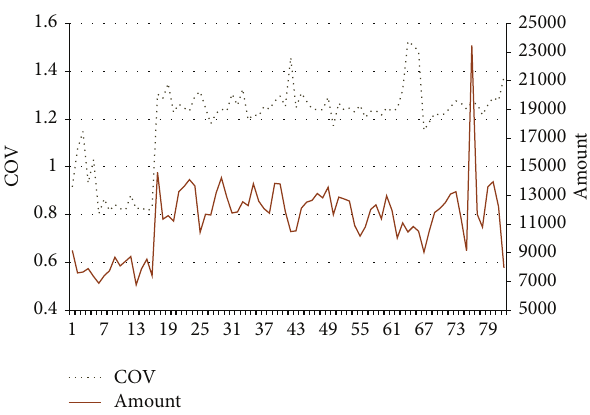
Figure 3: Variability in the coefficients of variation and vehicle numbers.